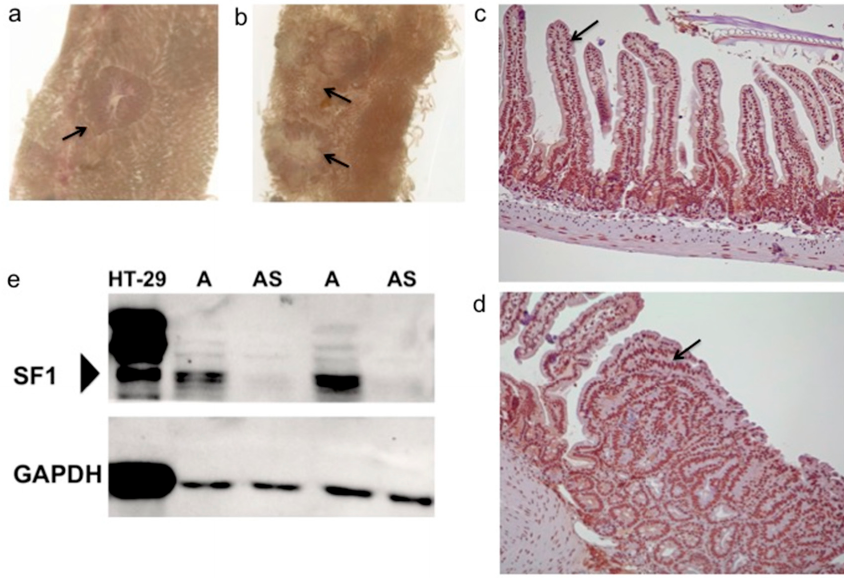
Figure 1. SF1 expression in the intestine. ( a , b ) Representative polyps (arrow) in the small intestine of 4-month old ApcMin/+;Sf1+/ − mice as viewed under the stereomicroscope. ( c ) Immunohistochemistry using anti-SF1 antibody of normal mouse intestine. Arrow indicates splicing factor 1 (SF1) expression in nuclei of intestinal villi and in ( d ) nuclei of adenoma cells of Apc Min/+ mice. ( e ) Immunoblotting using anti-SF1 antibody on cell lysate from HT-29 human colon cancer cells and lysates from Apc Min/+ (A) and ApcMin/+;Sf1+/ − (AS) mouse intestines. (Bottom) GAPDH expression in the samples.